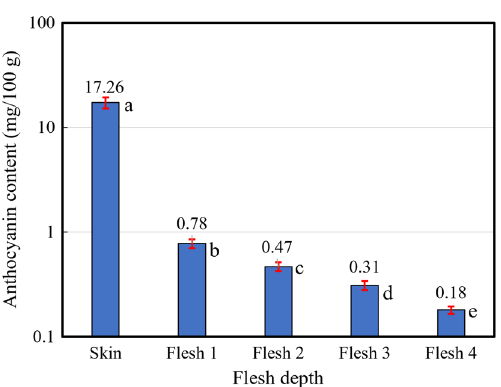
Figure 3. Anthocyanin contents in samples of skin and fleshes at different depths. Averages and standard errors of anthocyanin contents were indicated on a logarithmic scale. There were statistically significant differences between skin and flesh depth ( p =